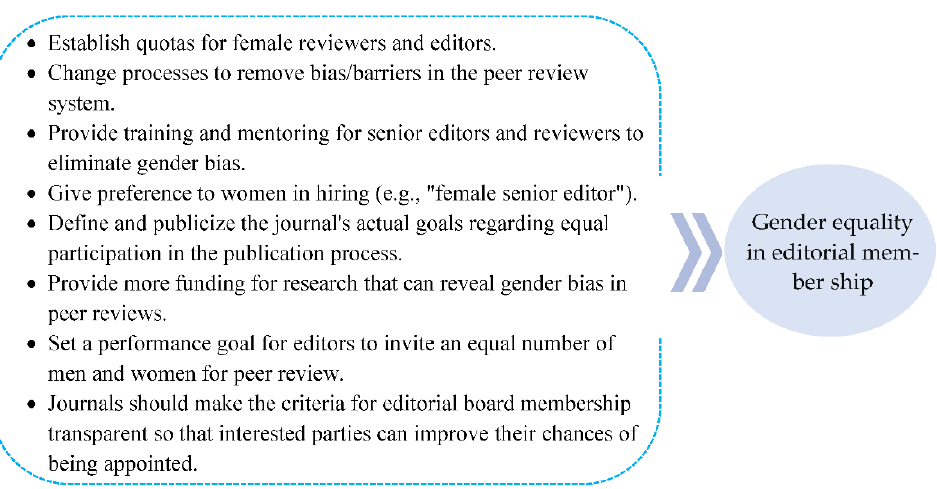
Figure 7. Some recommendations for developing gender equality in editorial membership positions.